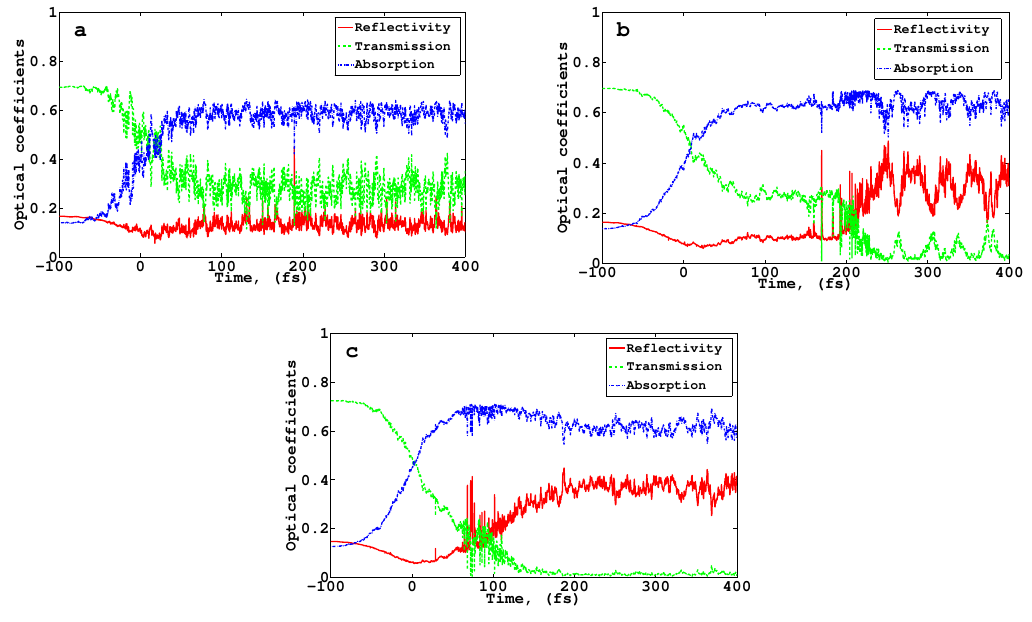
Figure 4. XTANT-modeled optical coefficients of diamond at different radiation doses absorbed: ( a ) 0.6 eV/atom; ( b ) 0.8 eV/atom; and ( c ) 1.0 eV/atom. Solid lines depict reflectivity coefficients, the dashed lines are transmission coefficients, the dot-dashed lines show absorption coefficients. The simulations were performed with 216 atoms in the supercell. Pump pulse maximum is at t = 0 fs. The figures ( a ) and ( c ) are reproduced from